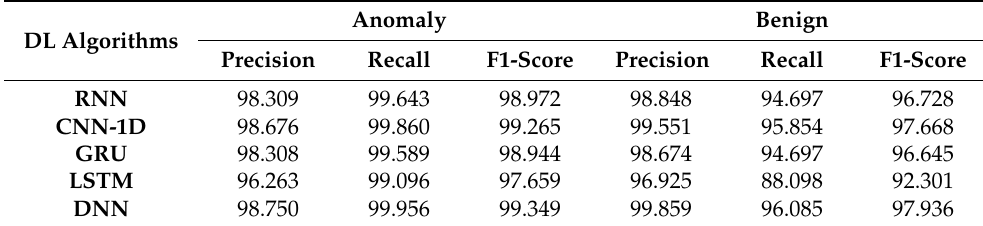
Table 5. Performance Evaluation metrics score of individual classes [%].